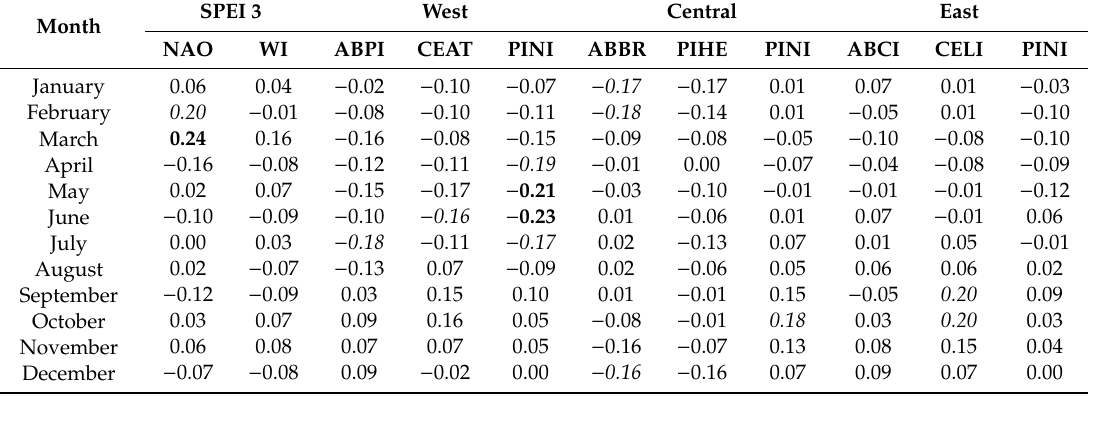
Table 4. Mann–Kendall statistic and related probability levels assessing NAO, WI, and site SPEI (3 months) trends for selected months during the period 1946–2010 and considering the nine Mediterranean study sites, p < 0.05 (italic values) and p < 0.01 (bold values).